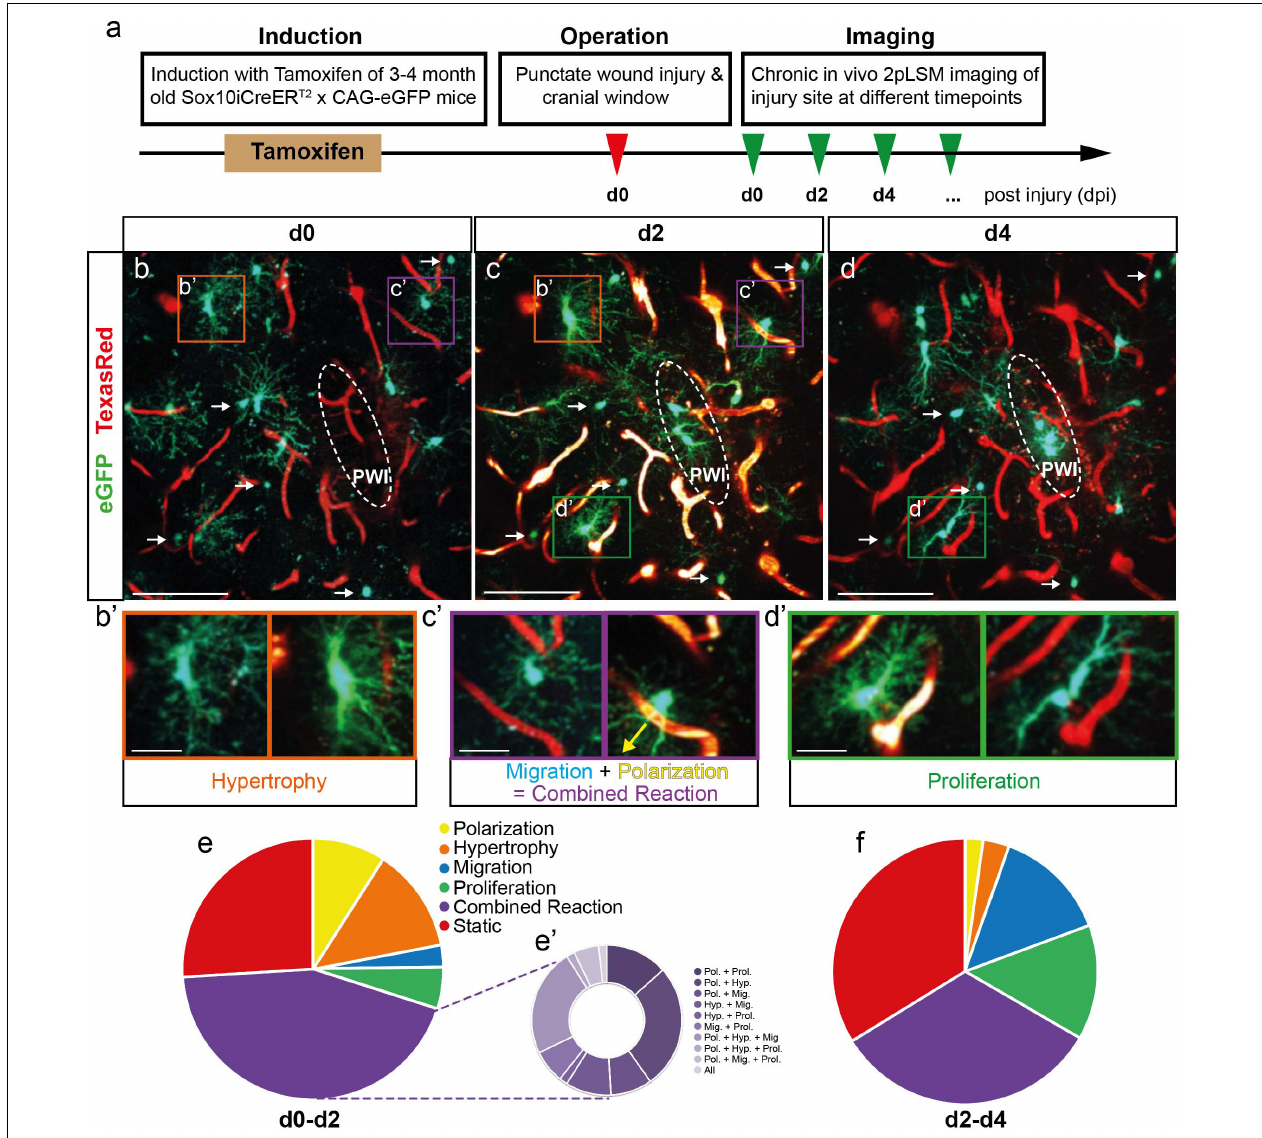
FIGURE 1 | Fast and heterogeneous reaction of NG2-glia after injury. (a) Schematic illustration of the experimental procedure. (b–d) Images of GFP + NG2-glia and oligodendrocytes (white arrows) surrounding a punctate wound injury (PWI; white dashed ellipse) at d0, d2, and d4 after the injury. Blood vessels are labeled with Texas-Red dextran (red). (b’–d’) Examples of cells (higher magnification from b–d ) showing hypertrophy (b’) , the combined reaction of migration and polarization toward the injury ( c’ ; yellow arrow indicates the direction towards the injury) and proliferation (d’) . (e–f) Pie charts represent the heterogeneous reaction of all NG2-glia surrounding the injury site between 0 and 2dpi ( e ; Polarization represents the cells polarizing toward the injury; the classification of the multiple reactions is represented in pie e’ ) and 2 and 4 dpi ( f ; n = 220 cells from 8 animals for d0–d2 and n = 180 cells from 6 animals for d2–d4). Images show maximum intensity projections of 30 µ m deep stacks. Scale bars represent 100 µ m in b–d and 25 µ m in b’–d’ .